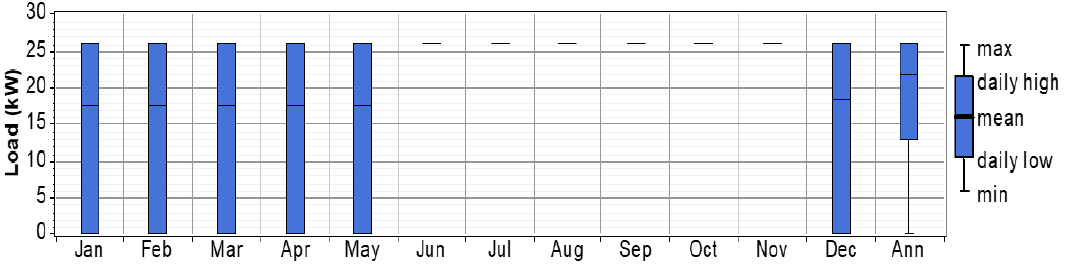
Figure 7. The seasonal profile of load demand.